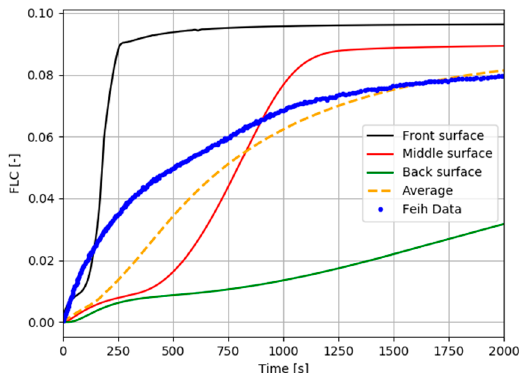
Figure 4. E-glass / vinyl ester material submitted to a heat flux of 50 kW / m 2 ; thermal through-thickness Figure 4. E-glass/vinyl ester material submitted to a heat flux of 50 kW/m 2 ; thermal through-thickness expansion profiles (fraction length change, expansion profiles (fraction length change, FLC).